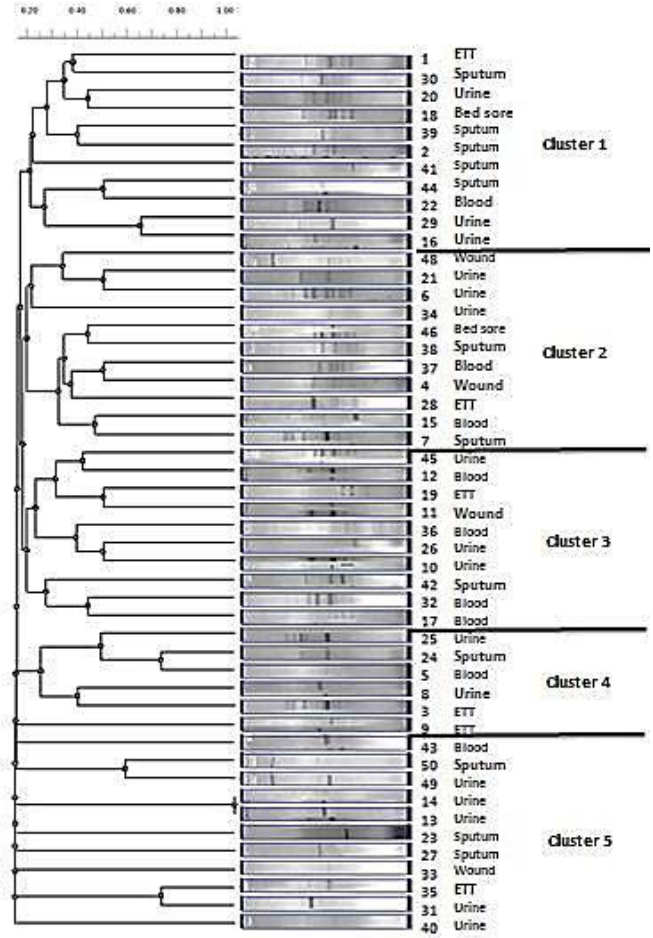
Fig. 4. Dendrogram generated with Dice coefficient and the UPGMA clustering method, showing the genetic similarity among K. pneumoniae isolates by Enterobacterial Repetitive Intergenic Consensus (ERIC)